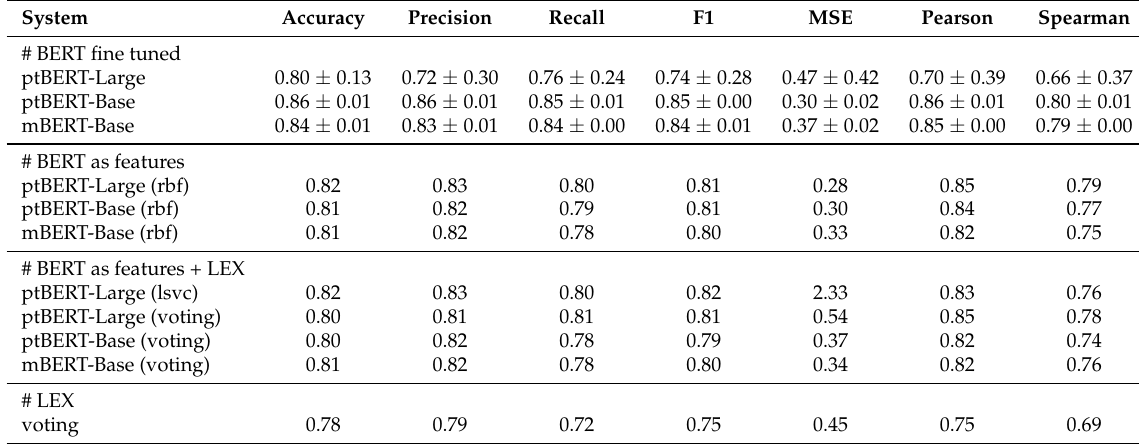
Table 9. SICK-BR NLI and STS results.